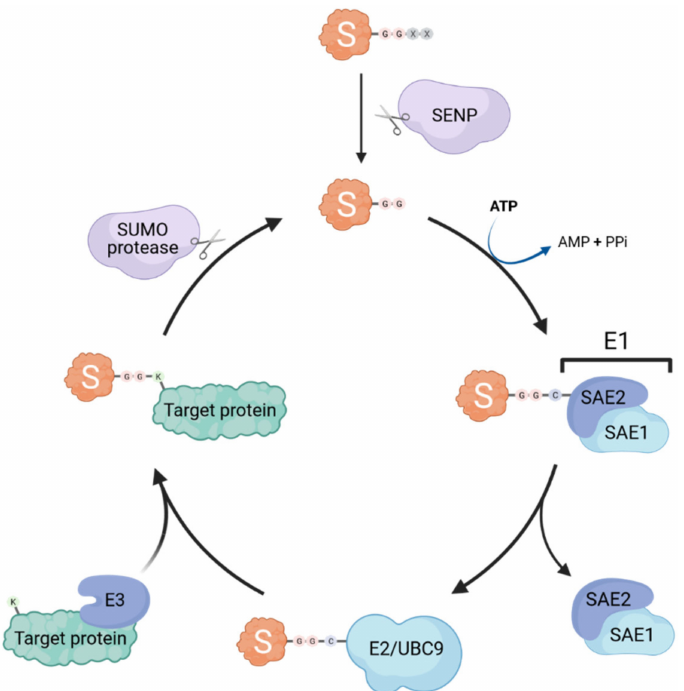
Figure 1. The SUMOylation machinery. Small ubiquitin-like modifiers (SUMOs; S in the cartoon) are covalently attached to lysine (K) residues in target proteins through the concerted action of dimeric E1 activating enzymes (SAE1/SAE2) and an E2 conjugating enzyme (UBC9). SUMOylation is usually aided by specific SUMO E3 ligases. SUMO specific proteases (e.g., SENP family members) can de- conjugate SUMO from its targets (known as deSUMOylation) and are also essential for the proteolytic maturation of SUMO precursors by cleaving off C-terminal residues to expose the di-glycine motif that is necessary for